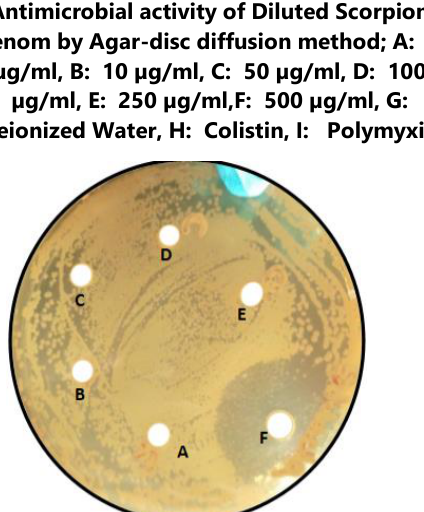
Figure 6: Acinetobactor baumannii; Antimicrobial activity of filtrate (<10KDa) and retentate (>10KDa) of scorpion venom; A: Crude Venom,